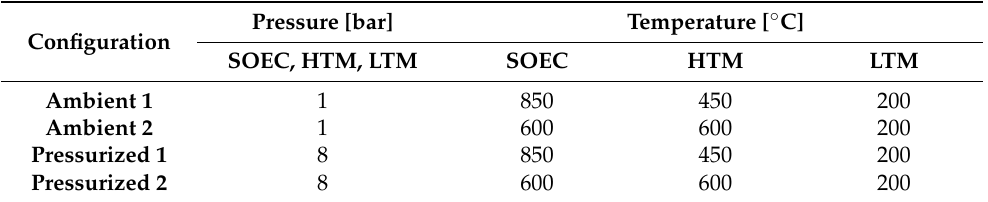
Table 1. Analyzed temperature-pressure configurations of the P2G